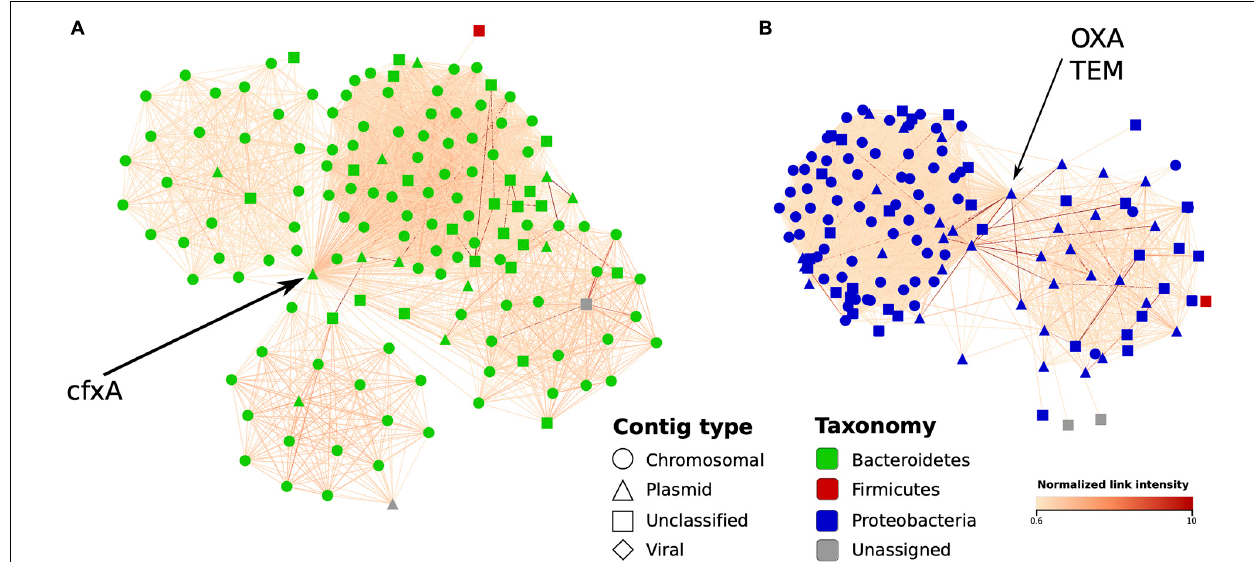
FIGURE 7 | Graph environment of selected antibiotic resistance genes in a Hi-C-based contig network (sample IC6). In each network, vertices correspond to contigs close to a contig containing an AR gene, while the edges – to Hi-C links between the contigs. The layout was constructed using the edge-weighted spring-embedded algorithm. Contig type is shown in shape and bacterial contigs’ taxonomy – in color; edge color denotes intensity of normalized Hi-C link. (A) The first graph region of interest: a plasmid-like contig carrying cfxA gene is linked to a cluster of contigs classified as belonging to Bacteroides genus. (B) The second region of interest: a plasmid-like contig carrying OXA and TEM genes linked to a cluster of contigs mostly classified as Klebsiella .